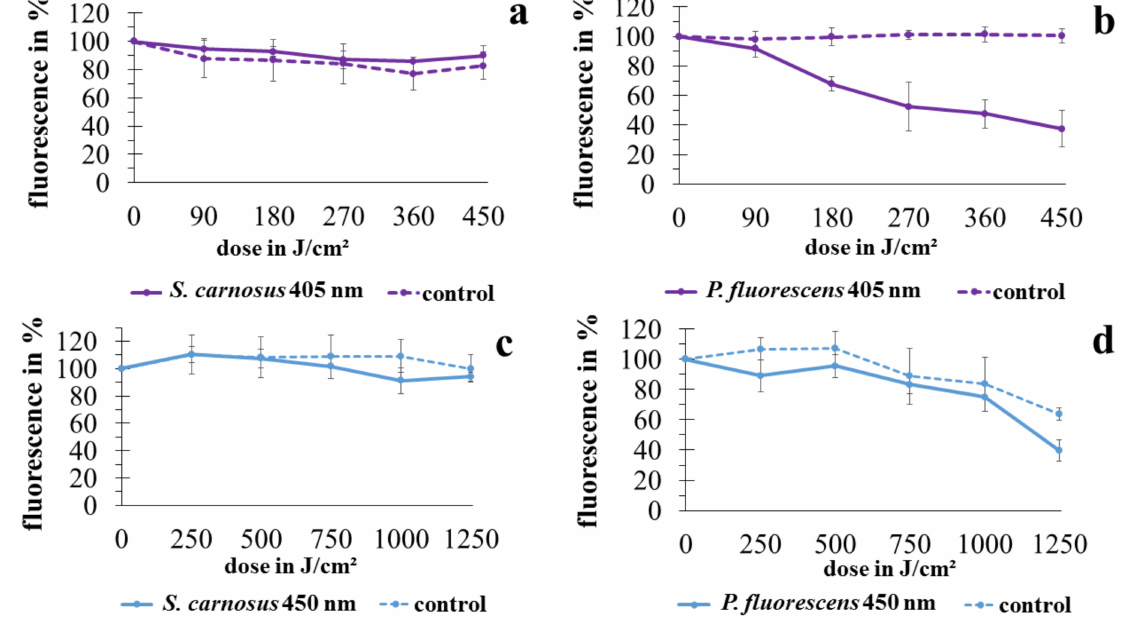
Figure 3. Fluorescence progress, related to membrane permeability for S. carnosus irradiated with 405 nm ( a ) and 450 nm ( c ) as well as for P. fluorescens at 405 nm ( b ) and 450 nm ( d ) irradiation. Error bars are representing the standard deviation of three independent experiments.